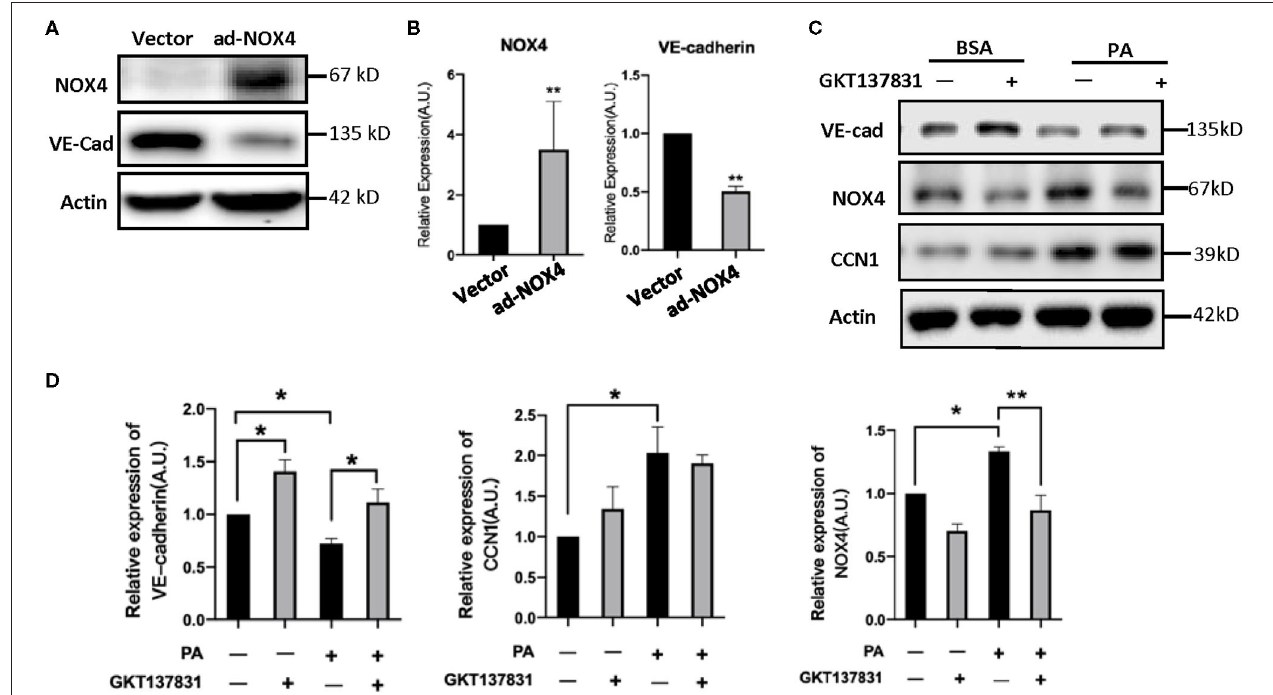
FIGURE 6 | CCN1 positive regulate the expression of NOX4 in HRVECs. (A,B) HRVECs infected with NOX4-overexpressed adenovirus or vector; (C,D) The active of NOX4 was inhibited by GKT137831 in HRVECs. * p < 0.05, ** p <